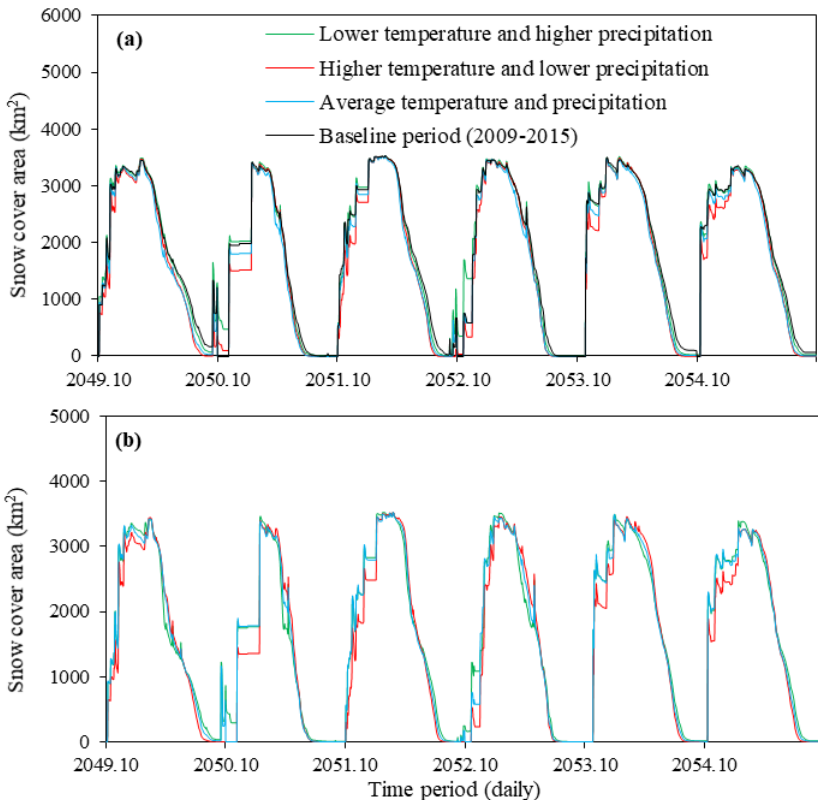
Figure 6. Projected SCA during the mid-21st century (2049–2055) under ( a ) RCP 4.5 and ( b ) RCP 8.5, in average, lower, and higher temperature and precipitation scenarios.